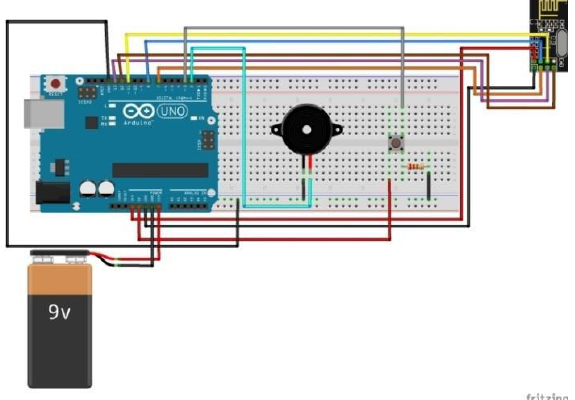
Figure 10. Breadboard implementation of transmitter